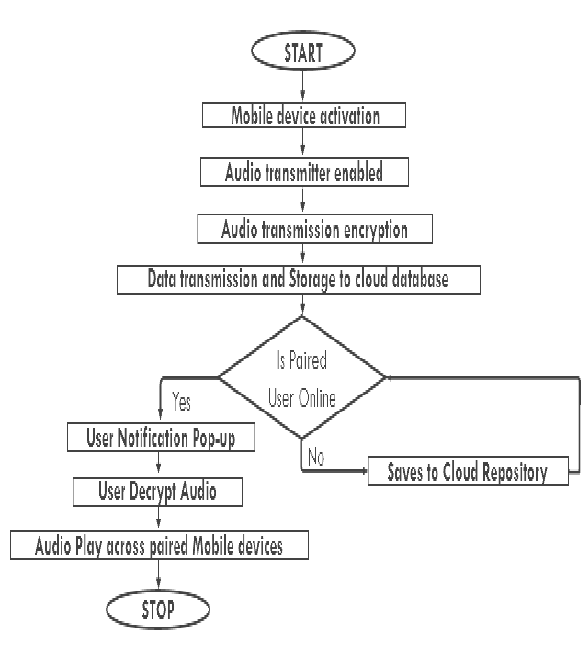
Figure 1 . System